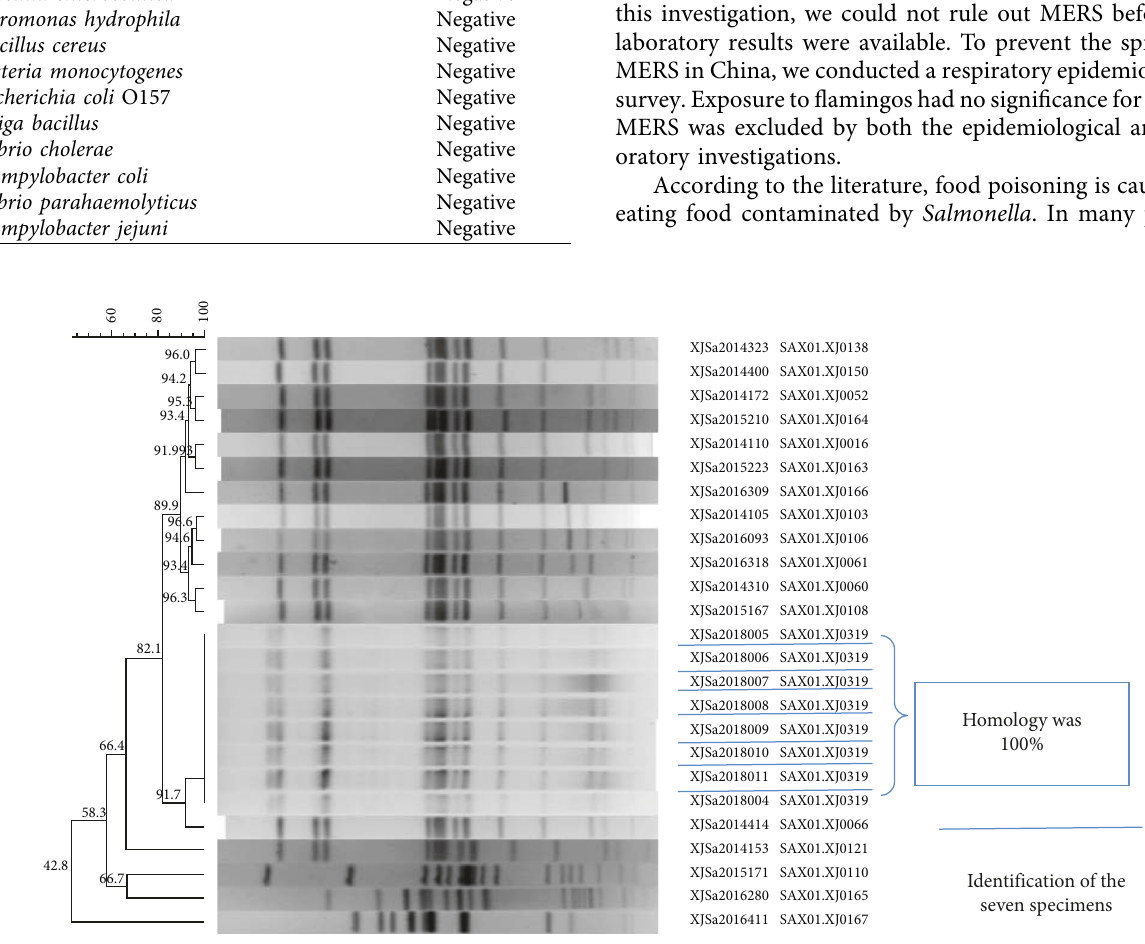
Figure 2: The results of the PFGE experiment.